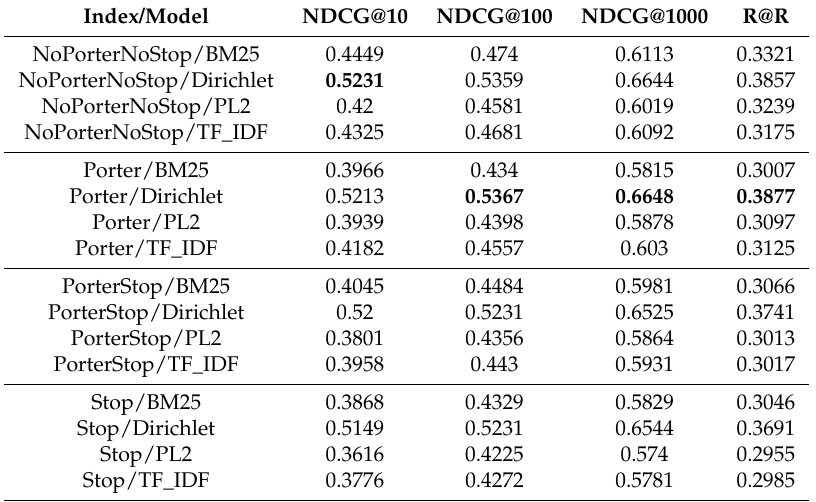
Table 7. T2: NDCG at various cut offs and Recall@R for the different models with QE+RF. The highest values are in bold.